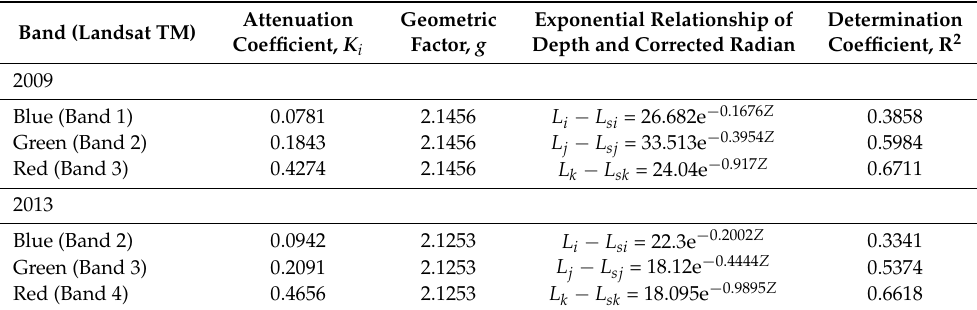
Table 8. Light attenuation used in water column correction on Landsat